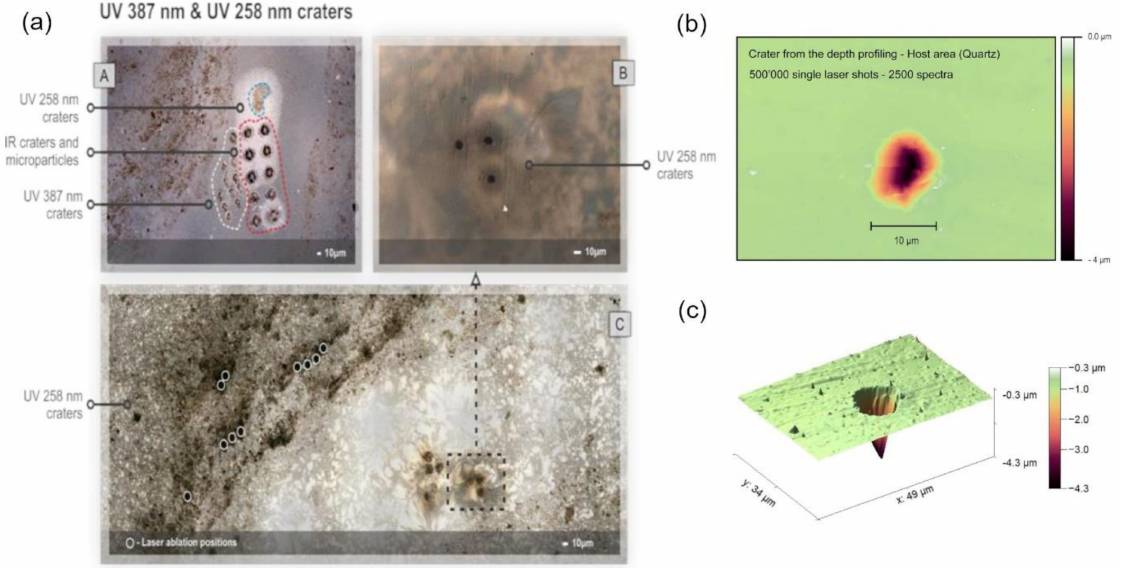
Figure 11. Panel ( a ): ( A ) Craters produced with different wavelengths. Red encircled area–IR 775 nm craters, white encircled area–UV 387 nm craters, and blue encircled area–UV 258 nm craters. ( B ) Close up look at the UV 258 nm craters. ( C ) Panoramic view of Gunflint chert sample with marked positions of UV 258 nm craters. Panel ( b ): Microscope z-scan image of the crater acquired from the depth profiling campaign with UV fs-laser radiation. Panel ( c ): Crater structure formed in this study